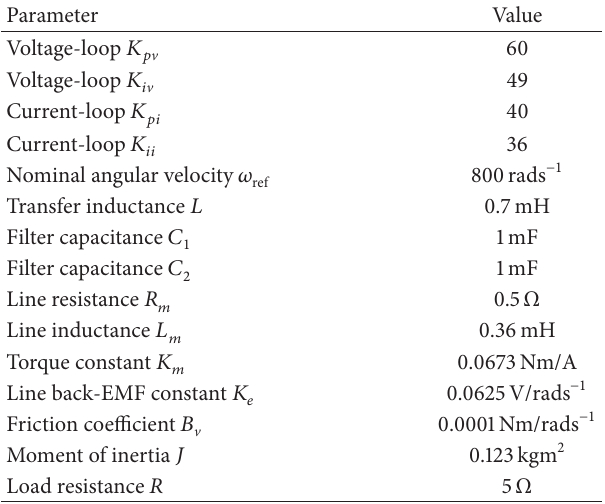
Table 3: Nomenclature for parameters with